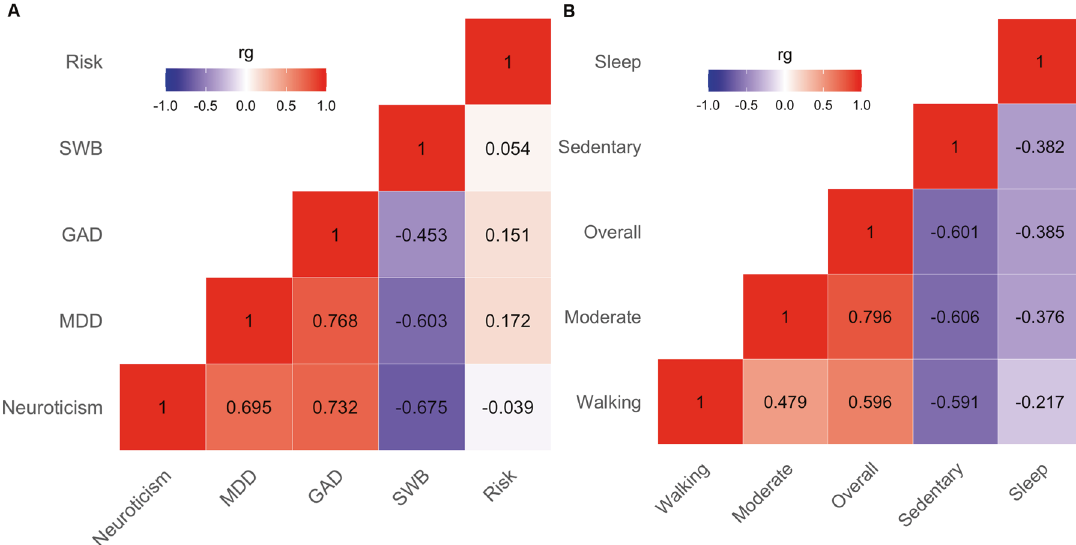
Fig. 3 Heatmap of bivariate genetic correlations. Pairwise genetic correlations were calculated separately for phenotypes of mental health ( A ) and those of physical activity ( B ). rg genetic correlation coef fi cient, GAD generalized anxiety disorder, MDD major depressive disorder, Risk risk tolerance, SWB subjective well-being.